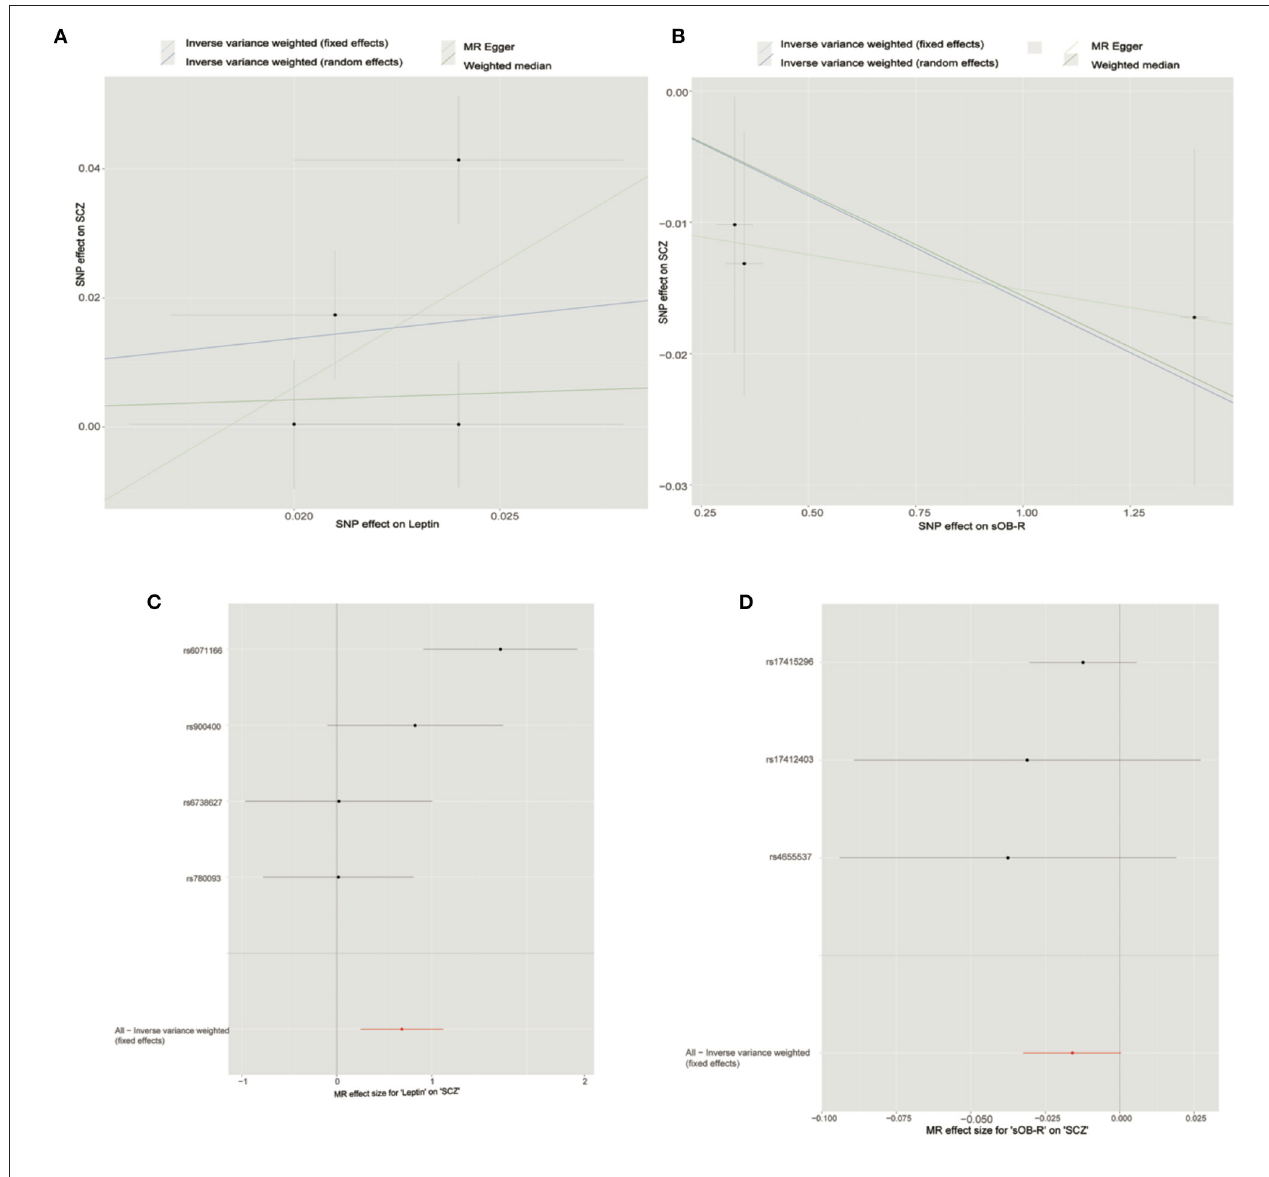
FIGURE 2 | Mendelian randomization analysis showing the effects of circulating leptin and soluble leptin receptor (sOB-R) levels on schizophrenia (SCZ) risk. (A) Mendelian randomization (MR) analyses of circulating leptin and SCZ. (B) MR analyses of sOB-R level and SCZ. (C) Forest plot for MR analyses of circulating leptin and SCZ. (D) Forest plot for MR analyses of sOB-R level and